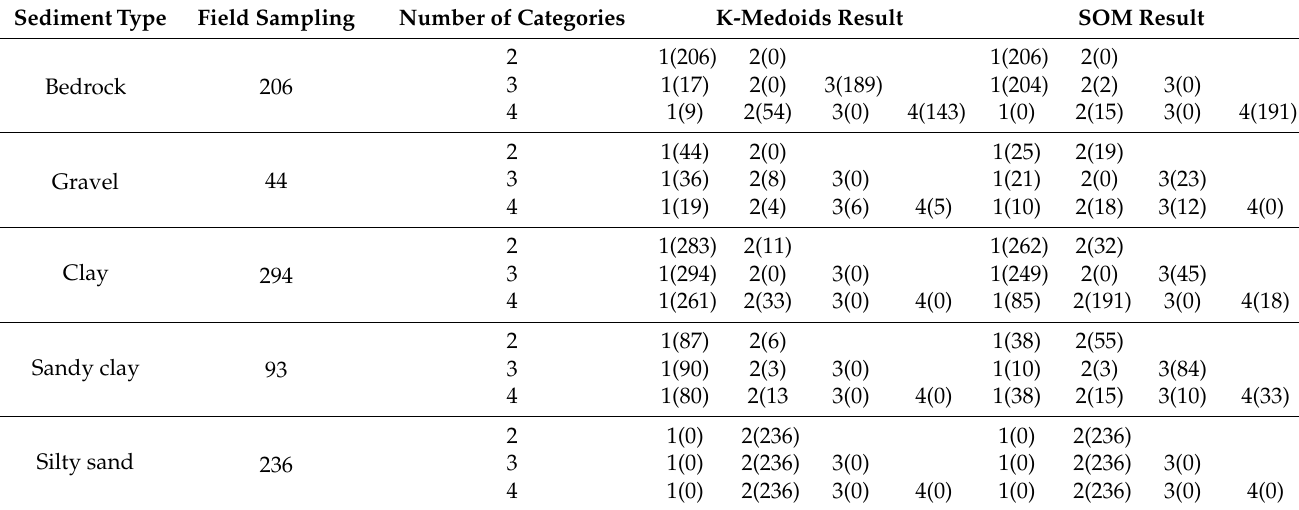
Table 3. The classification results of SOM and K-medoids for two to four